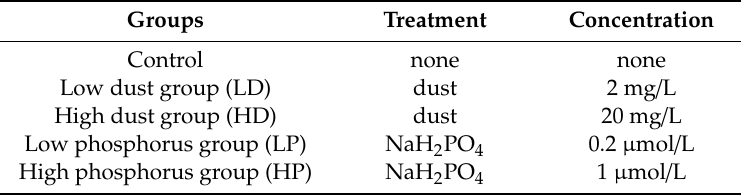
Table 2. Experiment design and concentrations of dust and